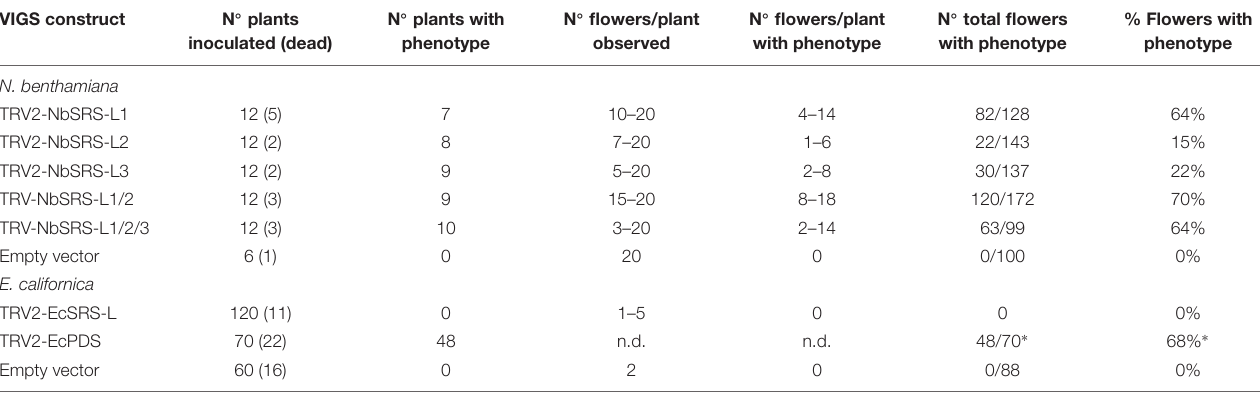
FIGURE 4 | Complementation phenotypes of Arabidopsis sty1 sty2 mutants transformed with 35S::NbSRS-L constructs. (A) Style and stigma phenotype of sty1 sty2 mutants. (B) Proportions of the different phenotypic categories among the T1 transgenic lines obtained for each construct, where N (gray) represents non-complemented lines, P (light green) partially complemented lines and F (dark green) fully complemented lines. (C–F) Examples of the different complementation categories among the transgenic lines. TABLE 1 | Summary of the VIGS experiments on Nicotiana benthamiana and Eschscholzia californica